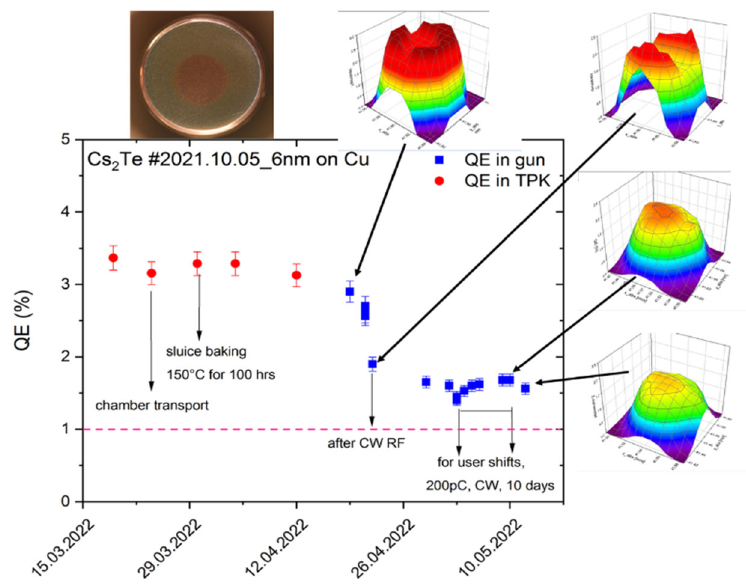
Figure 5. Performance of Cs 2 Te photocathode during cathode storage in SRF gun. Insertion: Cs 2 Te film on a copper plug and the QE mapping on different days [39].